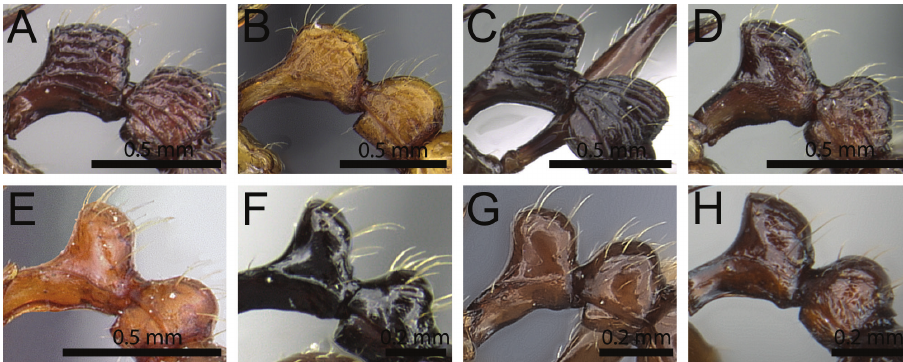
Figure 27. Petiole and postpetiole in profile. A T. aherni (CASENT0045755) B T. voasary (CASENT0247162) C T. ambanizana (CASENT0189238) D T. avaratra (CASENT0445167) E T. steinheili (CASENT0101258) F T. yammer (CASENT0042832) G T. alperti (CASENT0042547) H T. dysalum